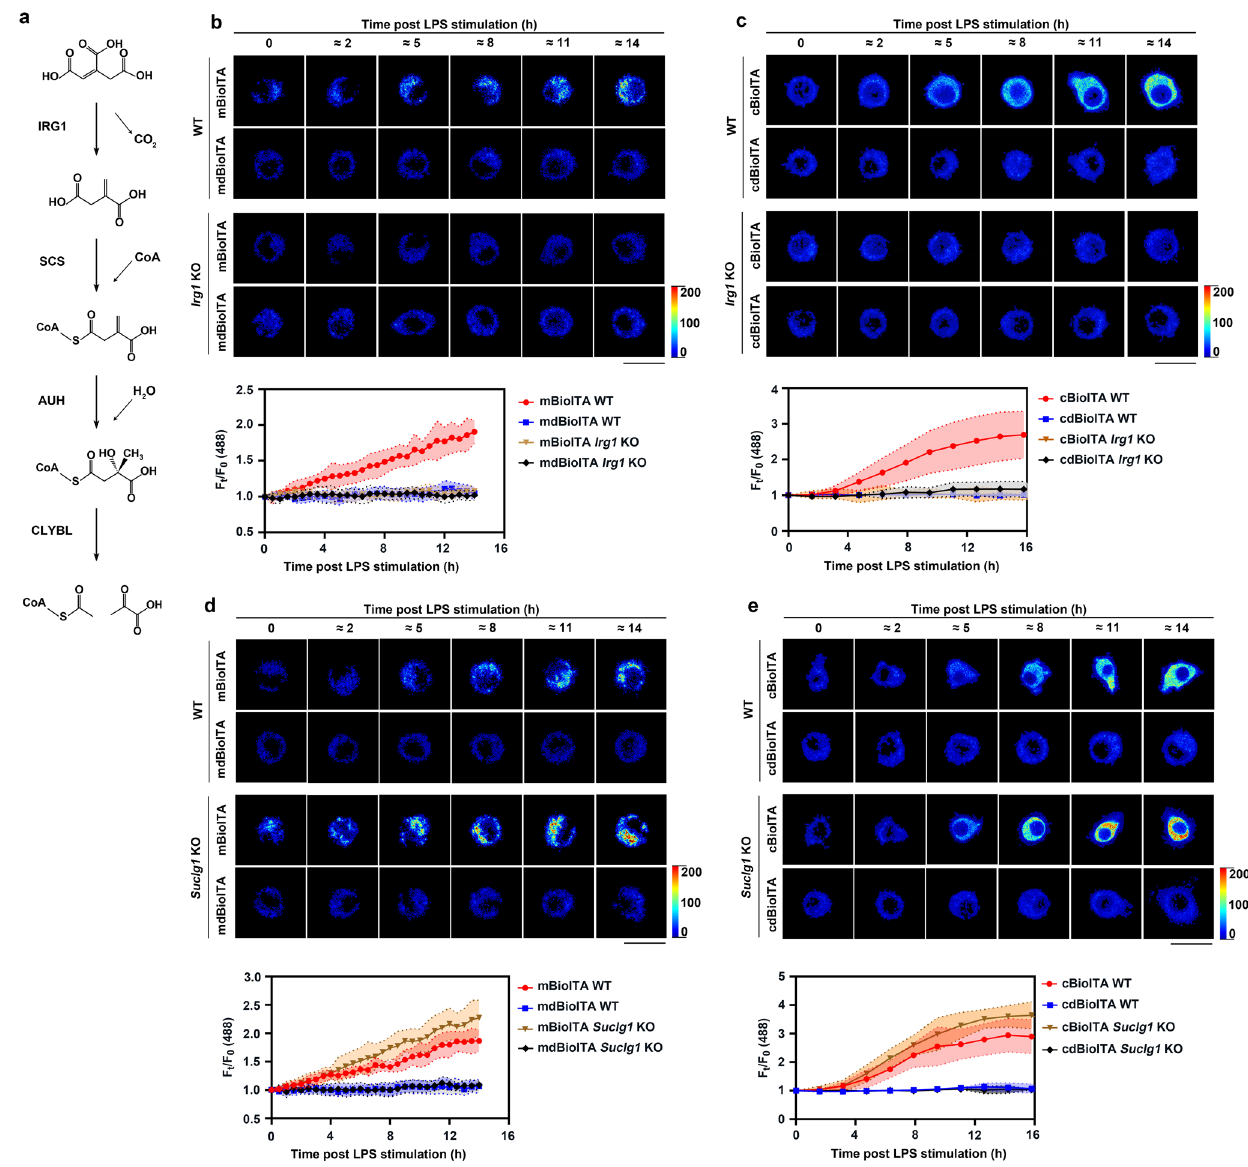
Fig. 4 | BioITA reports itaconate metabolism in living macrophages. a The central nodes for cellular itaconate metabolism. SCS, succinyl-CoA ligase; AUH, methylglutaconyl-CoA hydratase; CLYBL, citramalyl-CoA lyase. b , c Representative pseudo-colorimagesofmitochondrial( b )orcytosolic( c )BioITAinRAW264.7cells withorwithout Irg1 KOwerecapturedatdifferenttimepointsafterLPS(10ngml – 1 ) stimulation ( b , c , upper panels).Time-dependent fl uorescence intensity of BioITAs or dBioITA in individual cell after LPS stimulation was quantitated ( b , c , lower panels). Mitochondrial or cytosolic dBioITA served as a control. Scale bar, 20 μ m ( b , c , upper panels). Data are shown as mean±SD ( n =8) ( b , c , lower panels).